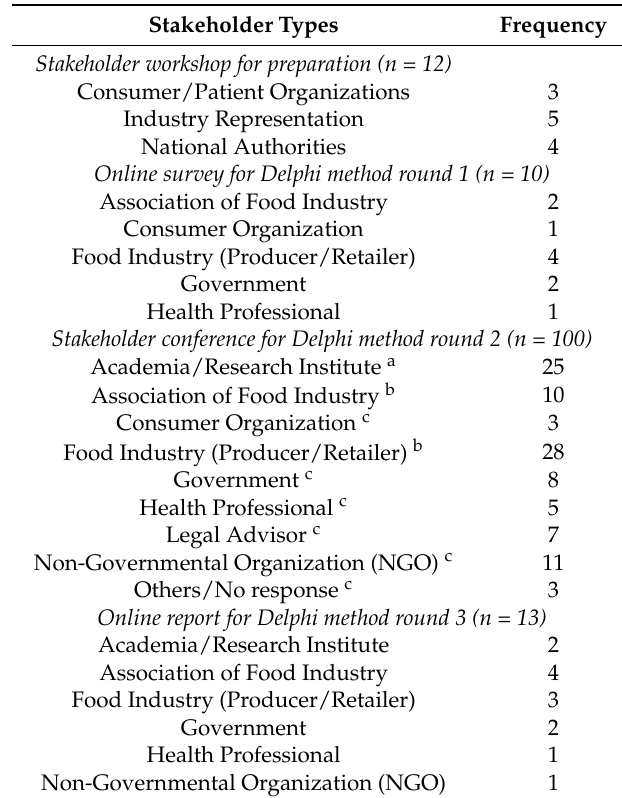
Table 1. Types of the participating